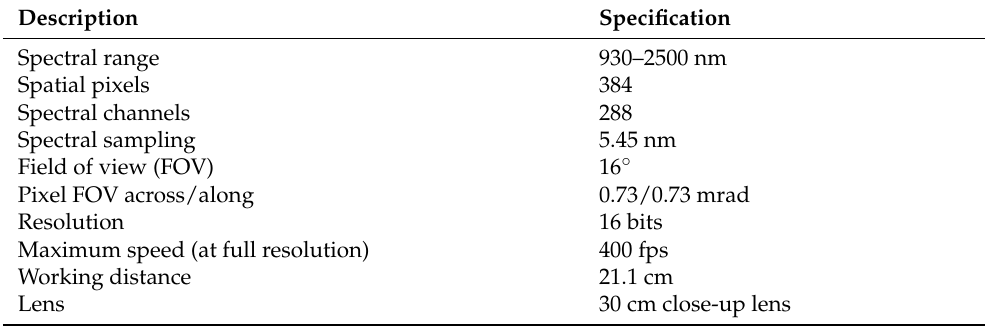
Table 1. HSI camera characteristics.